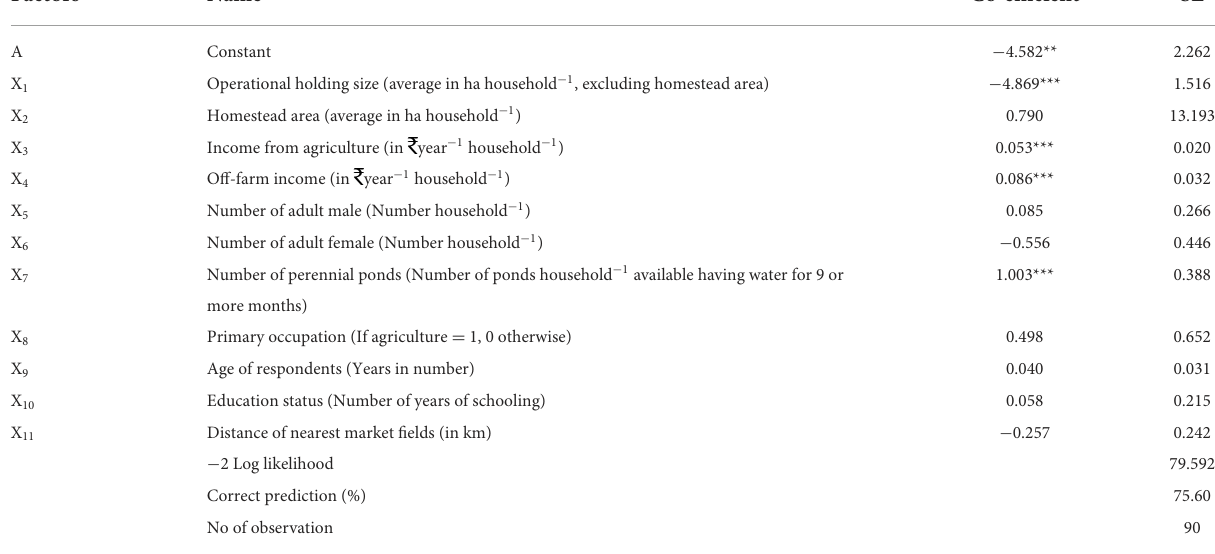
TABLE 7 Factors affecting adoption of higher cropping system